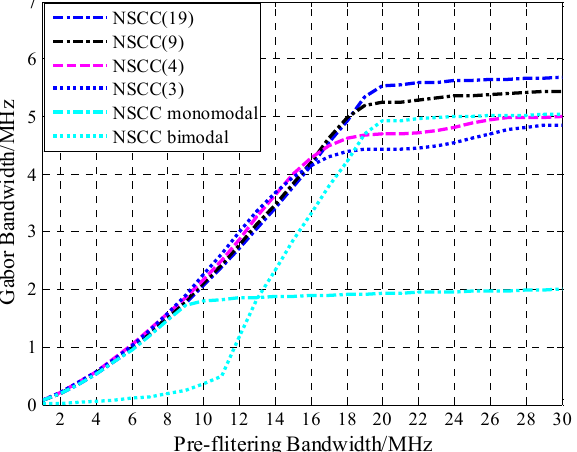
Figure 7. Gabor bandwidth for NSCCs.